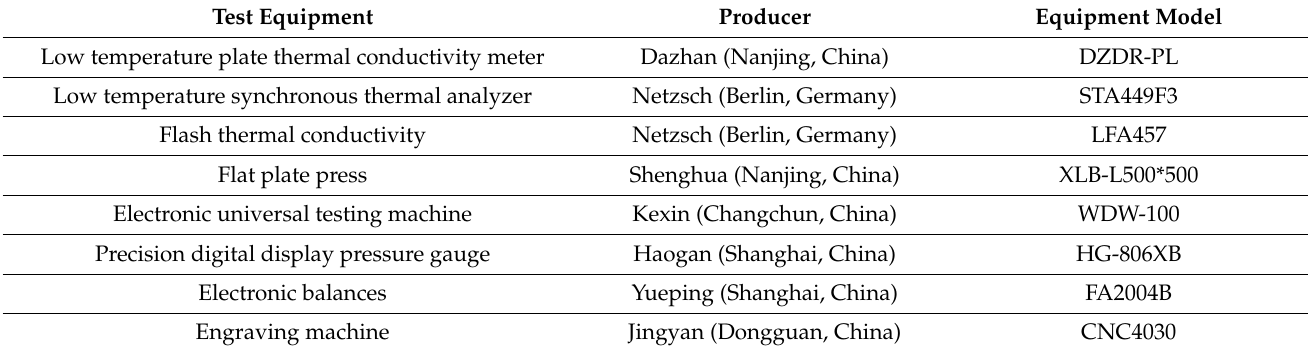
Table 2. Test device